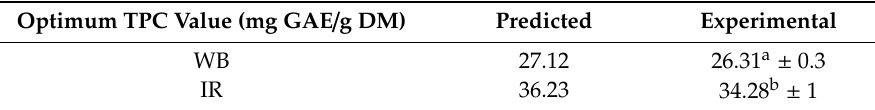
Table 5. Predicted and experimental results of TPC (mg GAE / g DM) for WB and